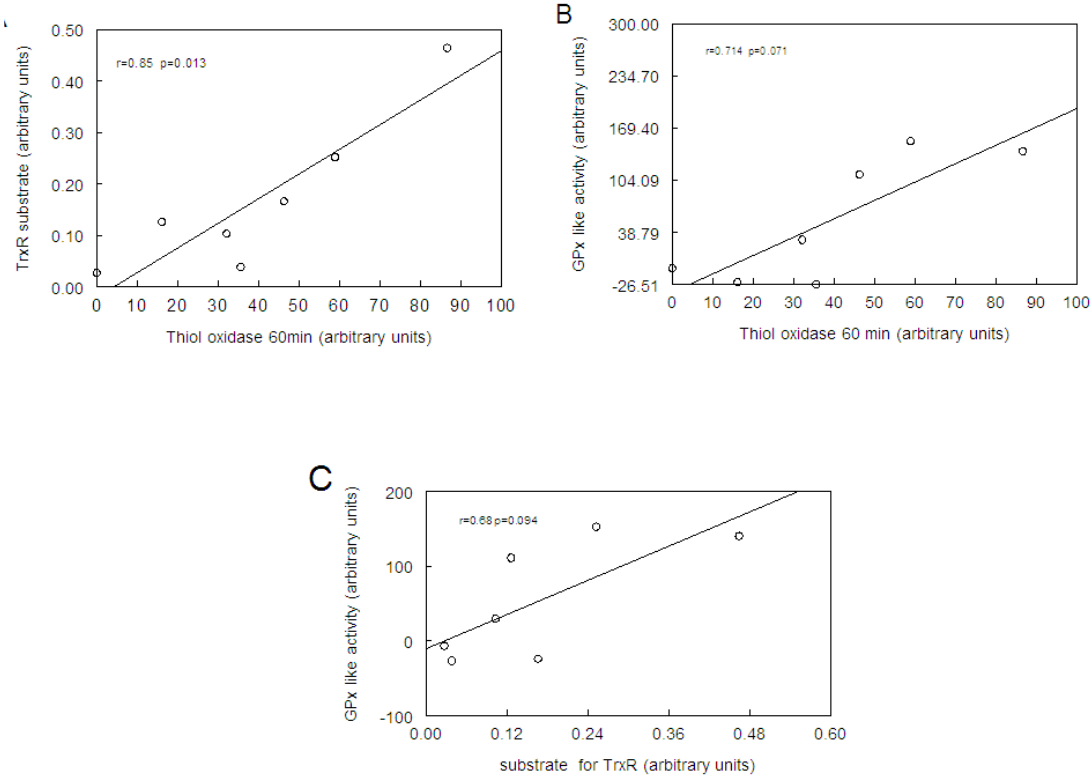
Figure 6. Correlation analysis (by Sperman rank test) between the thiol oxidase activity with the effectiveness of diselenides and ebselen as substrate of hepatic mammalian TrxR (A) or with thiol peroxidase-like activity (B) or and between thiol-peroxidase like activity and the effectiveness of diselenides and ebselen as substrates for TrxR (C).